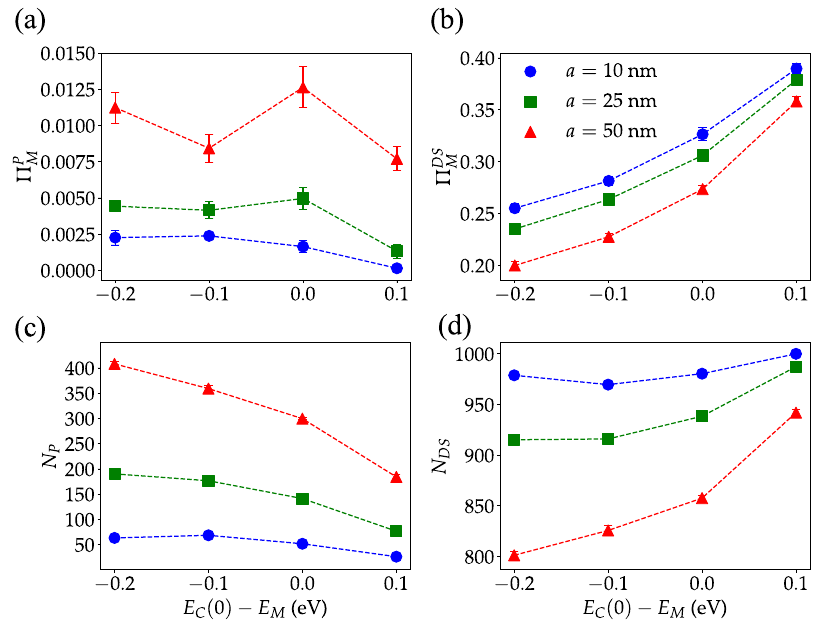
Fig. 7 Detuning dependence of polariton and dark-state contributions to molecular excited-state survival probability. a Total contribution of polariton states (states with >15% but <85% photonic content) to the molecular survival probability vs. cavity detuning with σ / Ω R = 0.2 and Ω R = 0.3 eV. b Total contribution of dark states (with greater than 85% molecular content) to the molecular survival probability. c . Estimated number of polariton states. d Estimated number of dark states. Dark states become more numerous and signi fi cantly more localized when the cavity-matter detuning goes from negative to positive. In addition, when a = 25 and 50 nm, while the number of polariton modes decreases signi fi cantly as E C (0) − E M goes from − 0.2 eV to 0 eV, the total polariton contribution to the molecular excited-state survival probability remains roughly the same indicating enhanced polariton delocalization at redshifted cavities. This effect is reduced when a = 10 nm. Each point corresponds to the average over 10 disorder realizations (error bars indicate standard